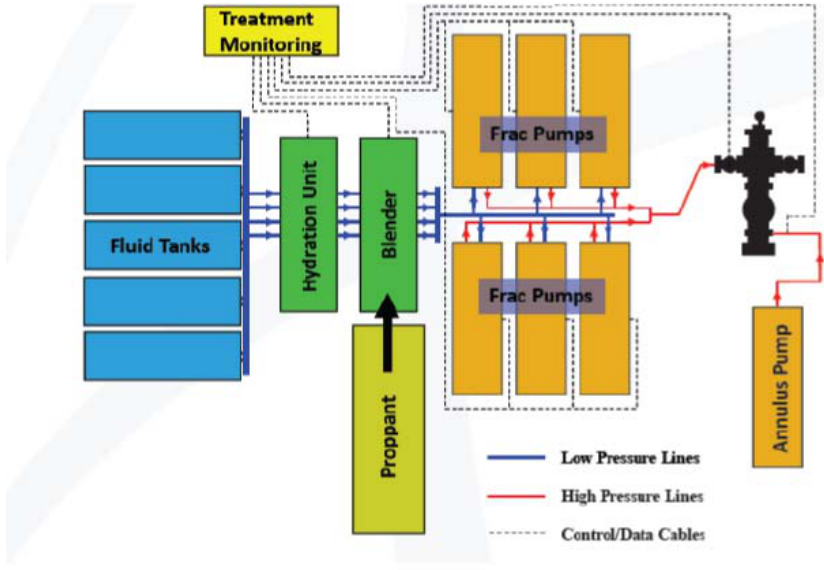
Figure 2. Hydraulic fracturing (HF) basic equipment.